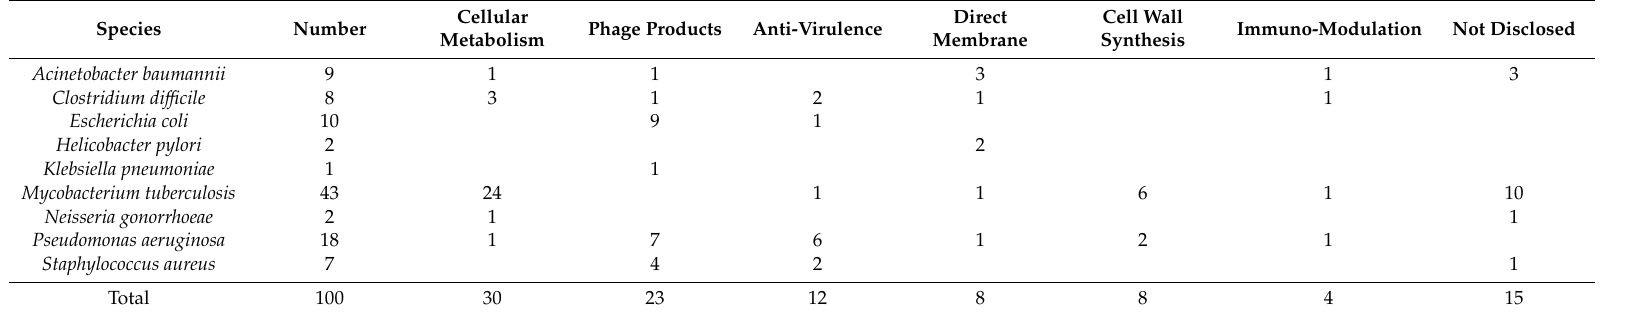
Table 2. Narrow-spectrum agents in preclinical development